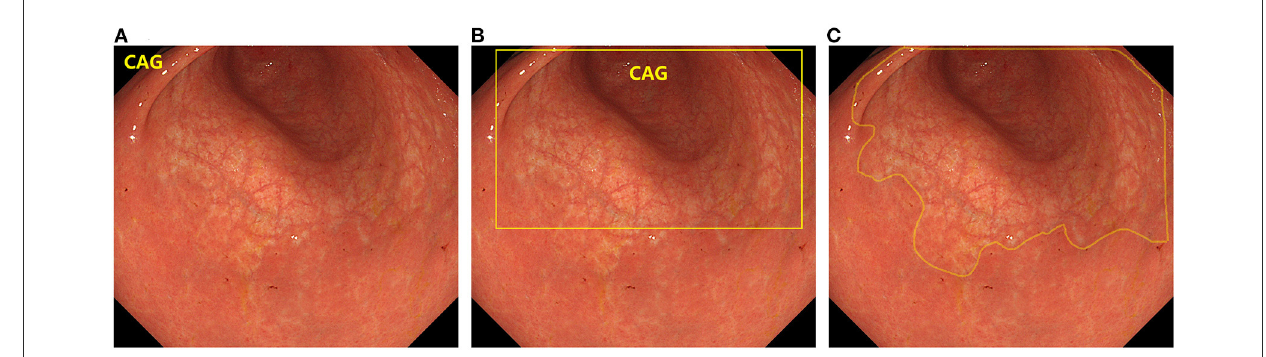
FIGURE1 The difference between the three types of deep learning algorithms. (A) Image classification. (B) Object detection. (C) Semantic